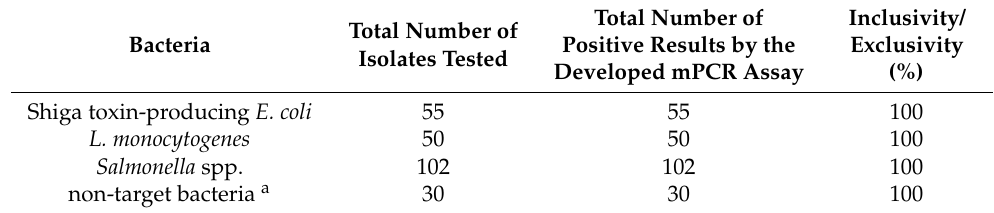
Table 5. Results of inclusivity and exclusivity study of developed mPCR assay for detection of three target bacteria and non-target